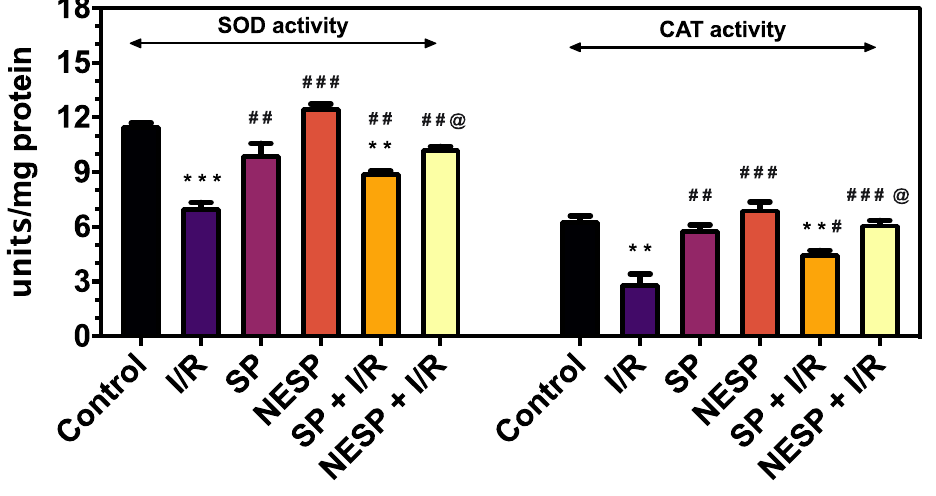
Figure 4. Renal superoxide dismutase (SOD) and catalase (CAT) activities in different animal groups ( n = 8) at the end of interventions: Control, ischemic/reperfusion (I/R), spironolactone (SP), nano-encapsulated spironolactone (NESP), spironolactone-treated I/R (SP + I/R) and NESP-treated I/R (NESP + I/R) groups. The data are represented as mean ± SD (Left panel: ** p < 0.01 and *** p < 0.001 compared to control group, ## p < 0. 01 and ### p < 0.001 compared to I/R group, @ p < 0.05: difference between SP-treated I/R group and NESP-treated I/R group). (Right panel: ** p < 0.01 compared to control group; # p < 0. 05, ## p < 0. 01 and ### p < 0.001 compared to I/R group; @ p < 0.05: difference between SP-treated I/R group and NESP-treated I/R group).